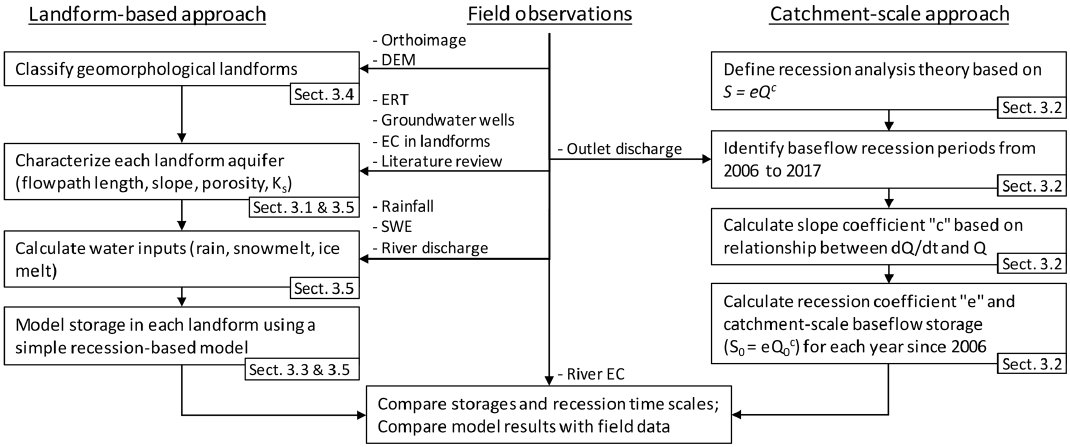
Figure 3. Sketch of the adopted workflow, separated between field observations and landform-based and catchment-based methods. The corresponding sections in the methodology are also highlighted. All abbreviations are detailed in the